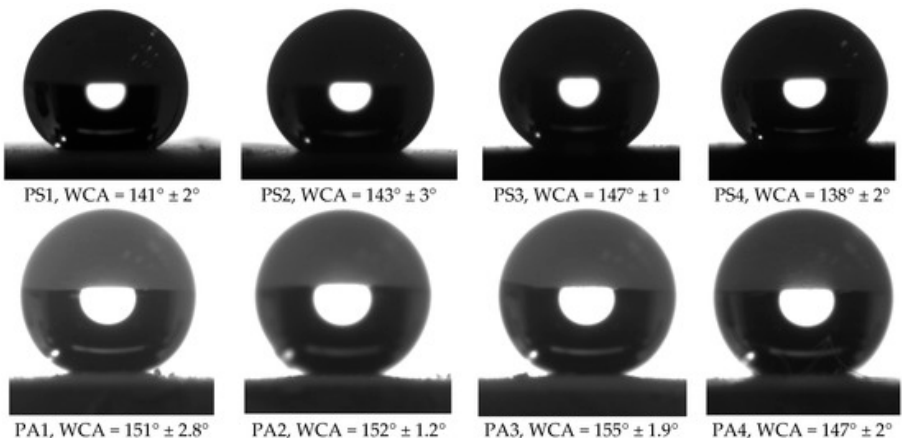
Figure 8. Snapshots of the measured water contact angle of only polystyrene (PS) fibres (PS1, PS2, PS3 and PS4) and PS/Al 2 O 3 fibres (PA1, PA2, PA3 and PA4). Reprinted with permission of [61].